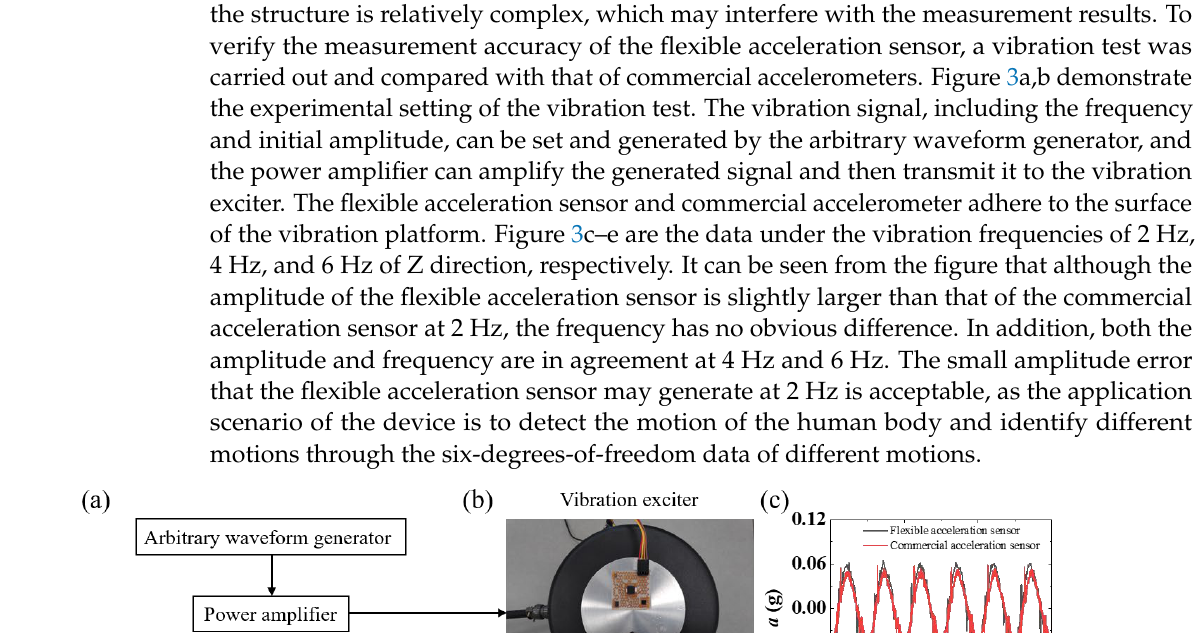
mensional schematic diagram of the flexible acceleration sensor. ( c ) Photograph of the flexible wear-